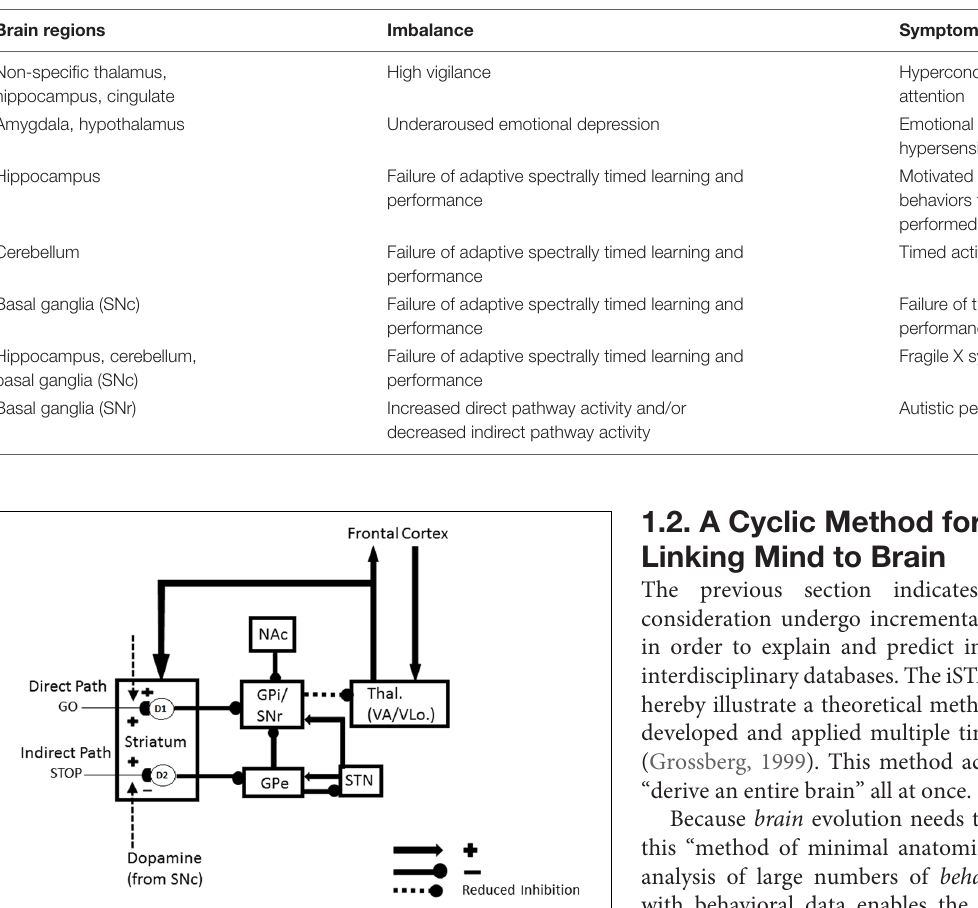
FIGURE 2 | Direct and indirect pathways in the basal ganglia. Excitatory connections end in arrows, inhibitory connections in disks. The basal ganglia direct pathway sends an inhibitory signal from the striatum to the external segment of the globus pallidus (GPi) or the substantia nigra pars reticulate (SNr). The latter regions inhibit the thalamus, and thus the thalamocortical loop. The net effect of inhibiting the GPi/SNr inhibition is to disinhibit the thalamocortical loop. Activation of the direct pathway hereby, at least under normal conditions, acts like a GO signal that enables action plans to be executed. The indirect pathway projects from the striatum to the external segment of the globus pallidus (GPe). The GPe then inhibits the GPi or SNr which, in turn, inhibit the thalamus. Activation of this succession of three inhibitory pathways can inhibit the thalamocortical loop and thereby STOP planned actions, even if there is activation in the direct pathway that would otherwise suffice to generate a GO signal. [Adapted with permission from Brown et al. (2004).] The nucleus accumbens (NAc) can also inhibit the GPi/SNr. Imbalanced activity within the NAc could lead to hyperactivity of the NAc output projection. This increases inhibition of the GPi, which disinhibits the thalamus, thus strengthening the GO signal while neutralizing the impact of the STOP signal. The GO signal can hereby be kept on for a long time, thereby enabling repetitive